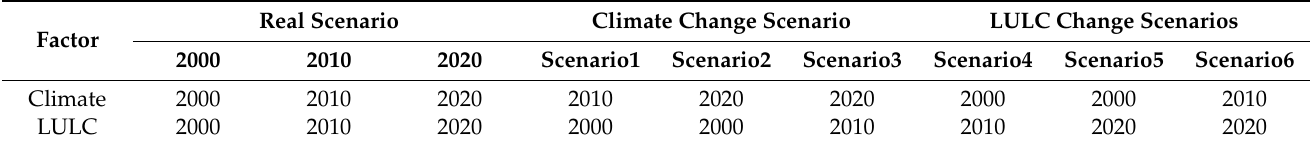
Table 2. The scenario settings of climate and LULC